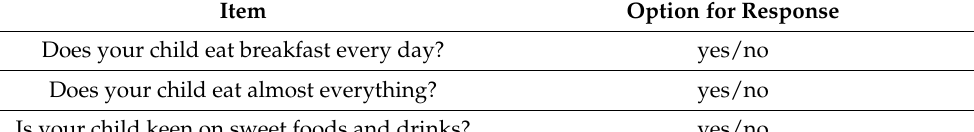
Table 1. Czech screening questionnaire for parents monitoring basic eating habits of their children. Item Option for